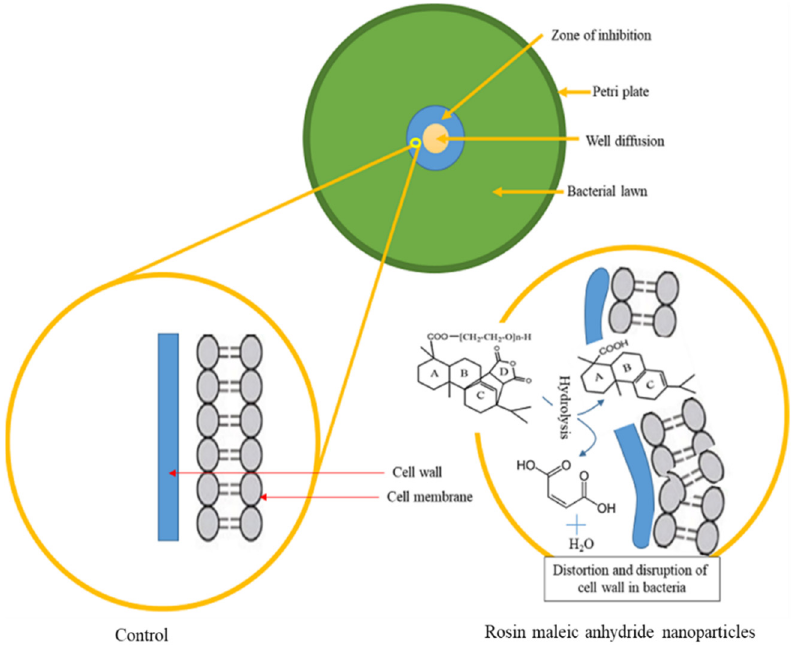
Figure 8. Rosin maleic anhydride nanoparticles’ proposed mode of action against